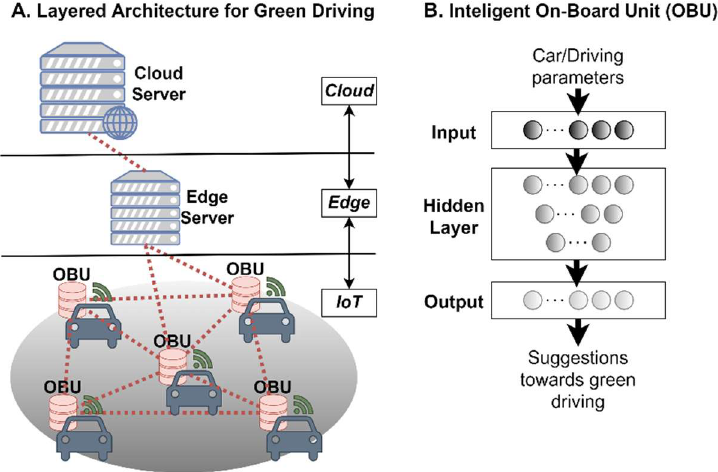
Figure 5. Resources and model sharing in the RAMOS architecture amongst the individual vehicles’ OBUs in the green driving